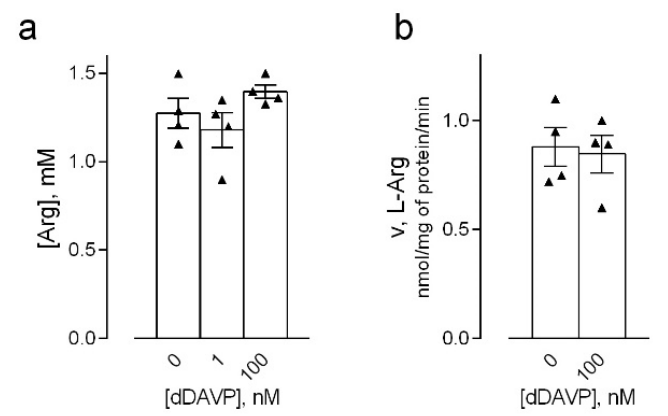
Figure 3. Arginine availability in desmopressin-treated human microvascular endothelial cells. HLMVEC were maintained for 24 h in the presence of the indicated concentrations of dDAVP. ( a ) Arginine intracellular concentration was measured through HPLC analysis after ninhydrin derivat- ization (see Material and Methods). Data are means ± SEM of three independent determinations. ( b ) Arginine uptake was assayed with a 30-s incubation of the cells in EBSS containing L-[ 3 H]arginine (100 μ M, 4 μ Ci/mL), as described in Material and Methods. Data are means ± SD of three determi- nations in a representative experiment that, repeated three times, gave comparable results.